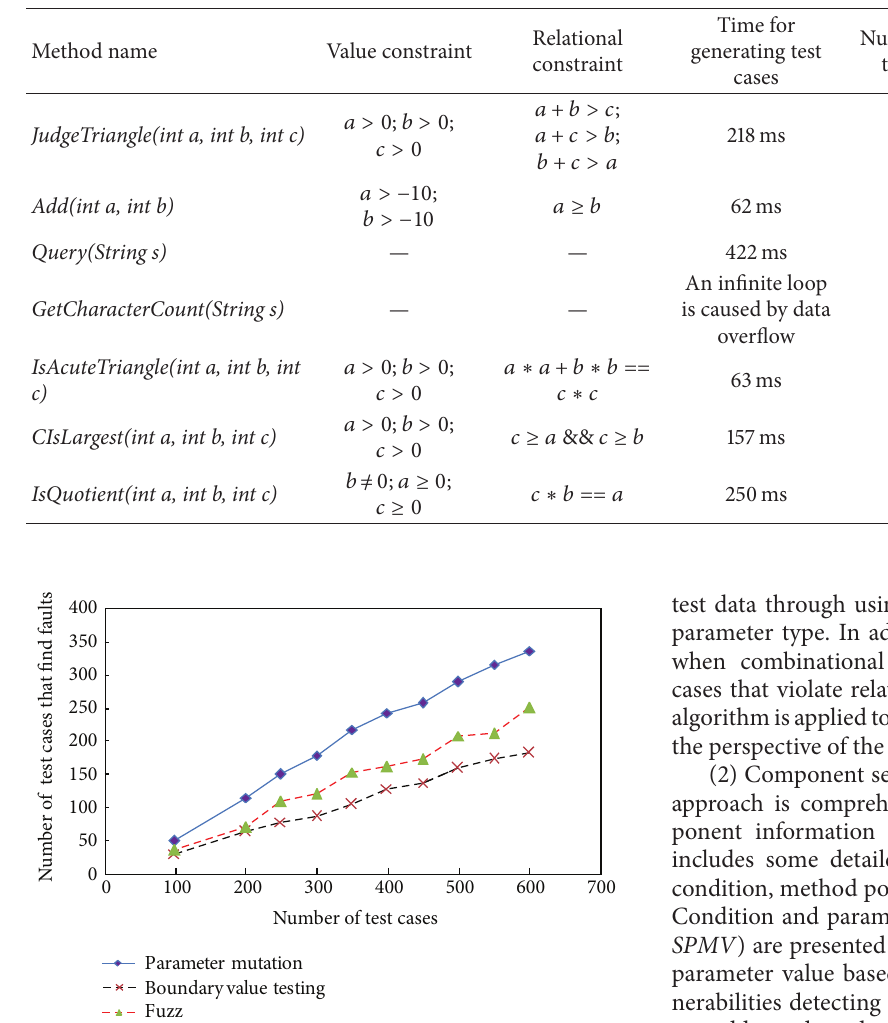
Table 7: The testing result of parameter mutation.